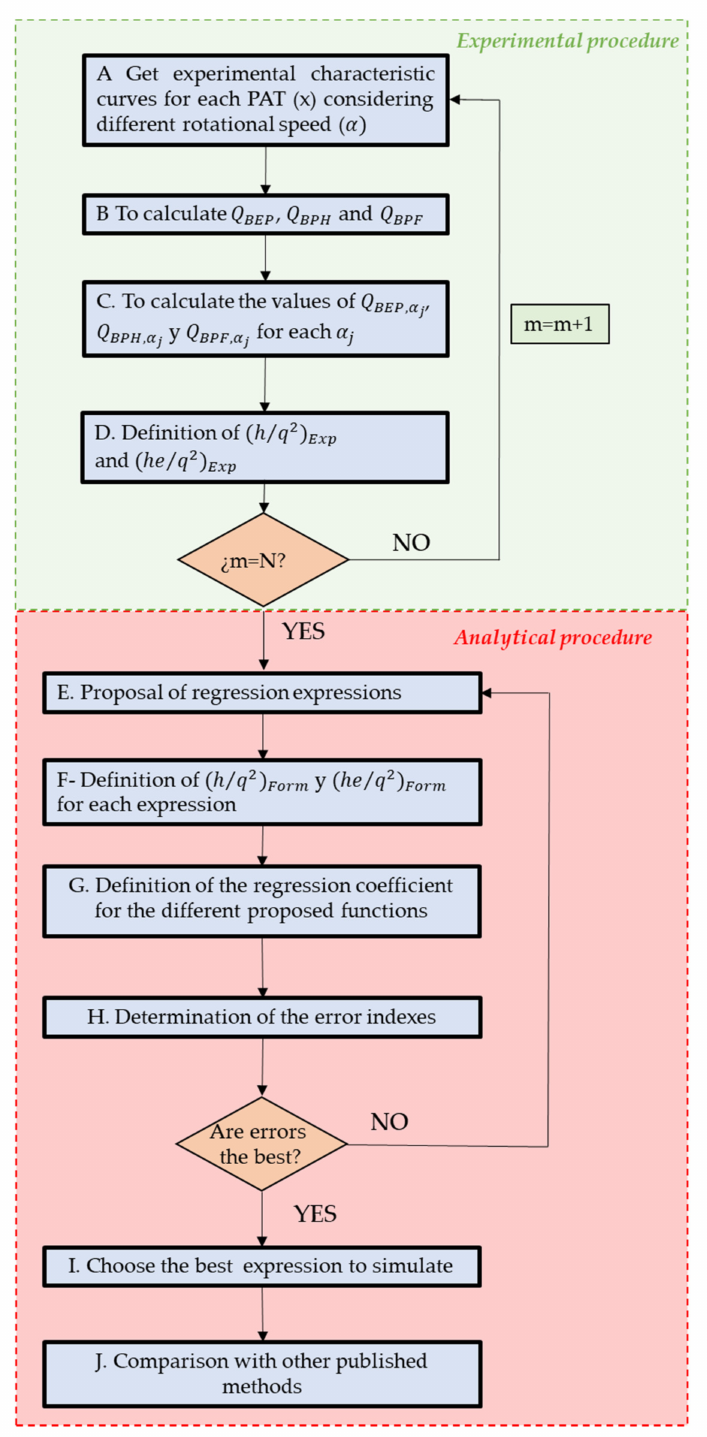
Figure 2. The methodology proposed to reach the expressions. Step E. It is the first step of the second phase, where the best regression expression will be defined. In this step, different functions are proposed and analysed using the database. Table 3 shows the regression expression, which is used in the